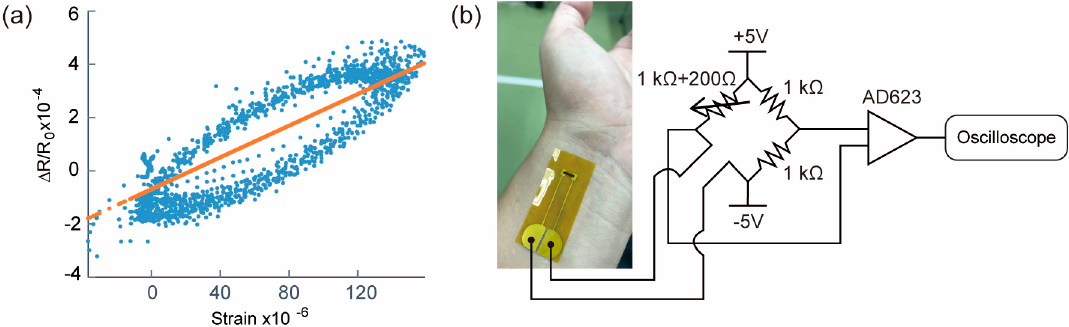
Figure 7. ( a ) Relationship between strain and the relative resistance change of the ultrathin piezoresistive Si on film. ( b ) Schematic of the blood pulse measuring setup.